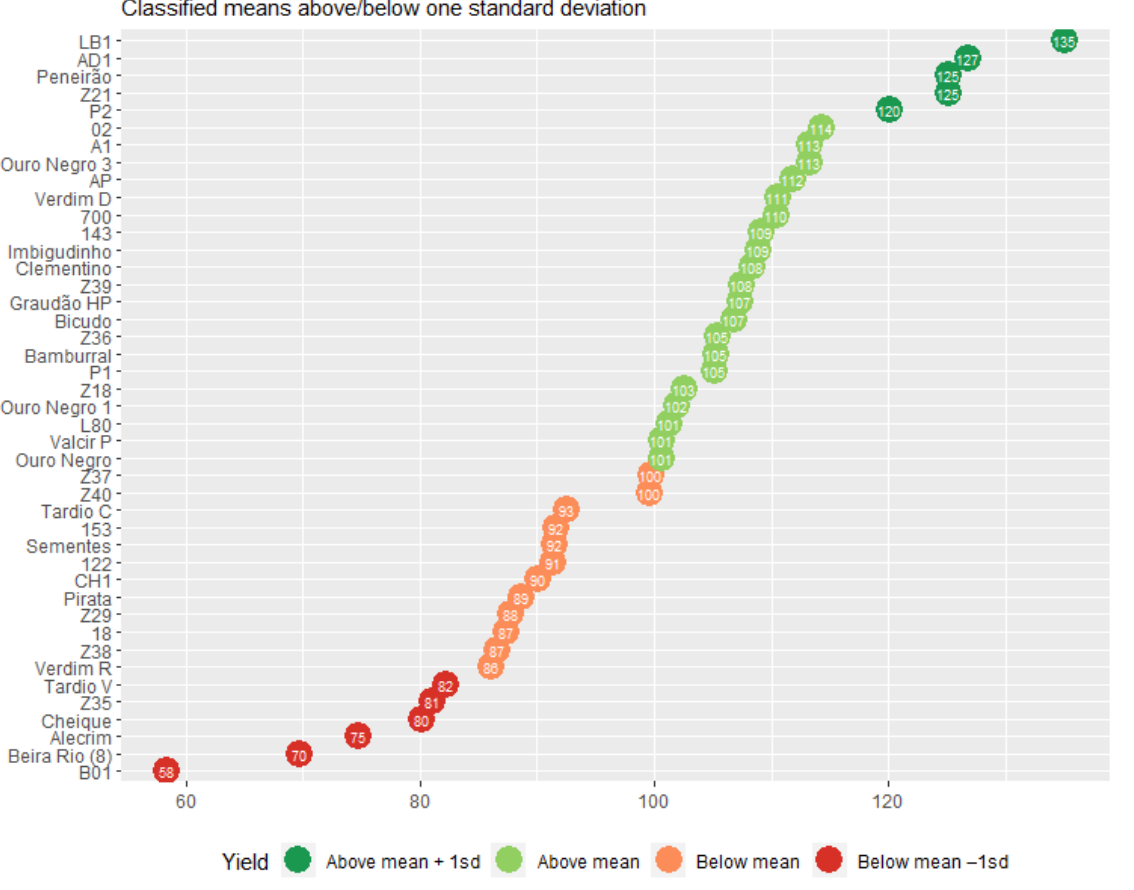
Figure 2. Yield average estimates for four harvests for 43 coffee (Coffea canephora) genotypes grown in Bahia and Espírito Santo. Means were grouped into values above one standard deviation from the mean, above the mean, below the mean, and below one standard deviation from the mean.